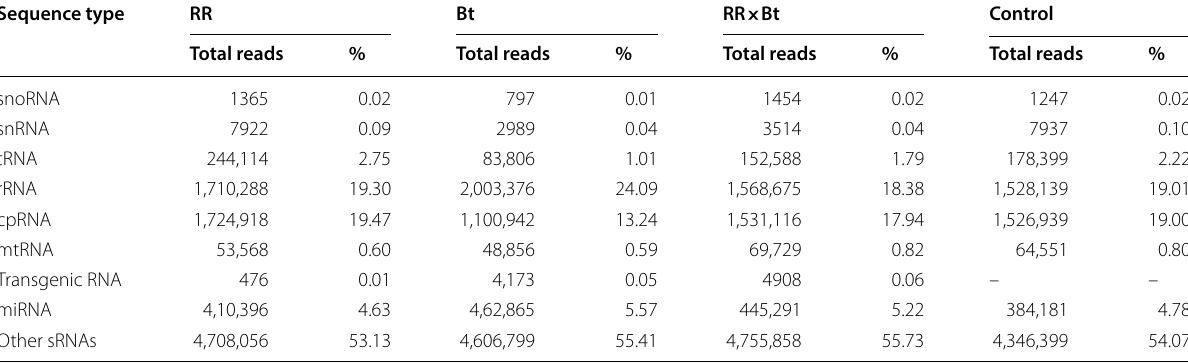
Table 1 Number of reads aligned to each sequence type for each of the four varieties used in the study Sequence